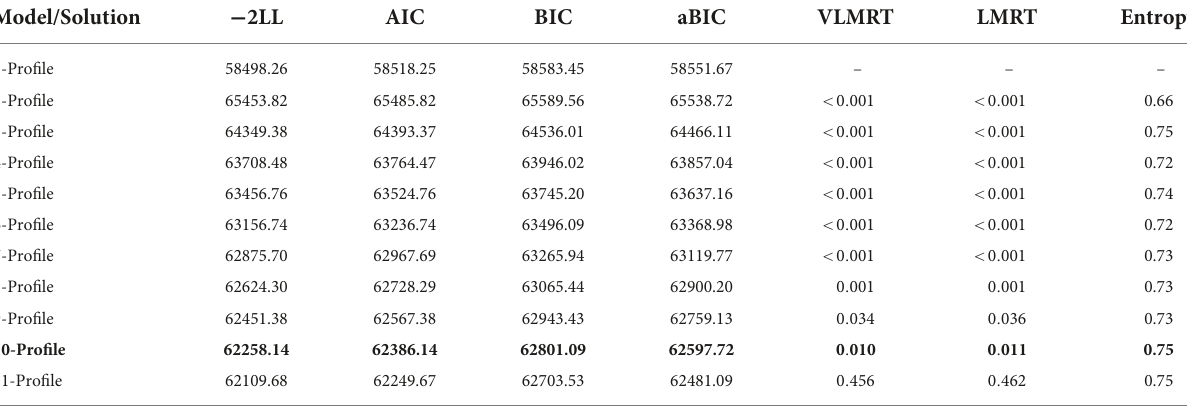
TABLE 2 Model fit indices for latent profile analyses.